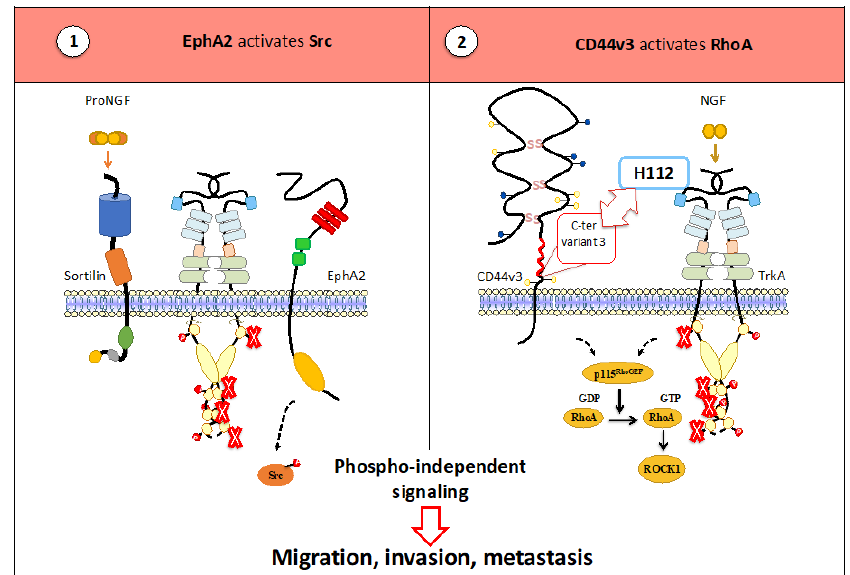
Figure 4. EphA2 and CD44v3 promote the activation of a TrkA phospho-independent pathway. ( 1 ) Following ProNGF stimulation, the TrkA/EphA2 association occurs and permits Src phosphorylation independently of TrkA phosphorylation. ( 2 ) Following NGF stimulation, TrkA interacts with CD44v3. CD44v3 permits RhoA activation independently of TrkA phosphorylation. As a result, TrkA/CD44v3 and TrkA/EphA2 contribute to breast cancer aggressiveness and TKI failure.